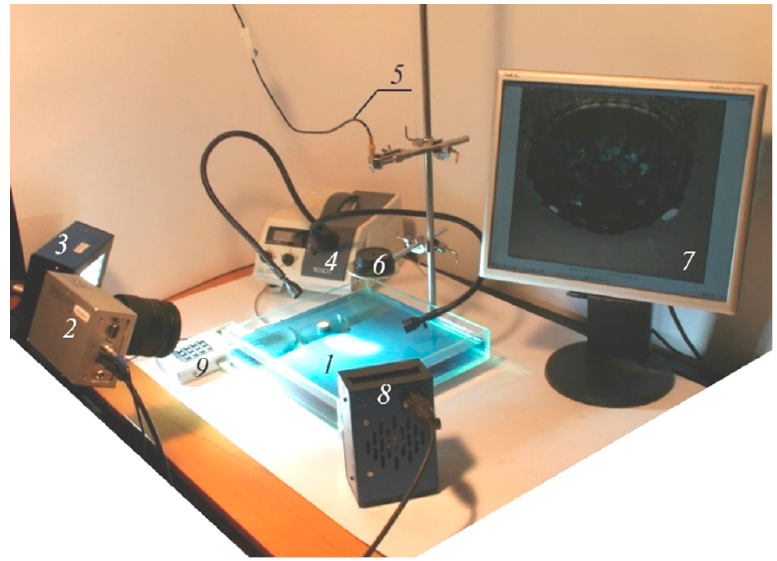
Figure 2. Experimental setup.